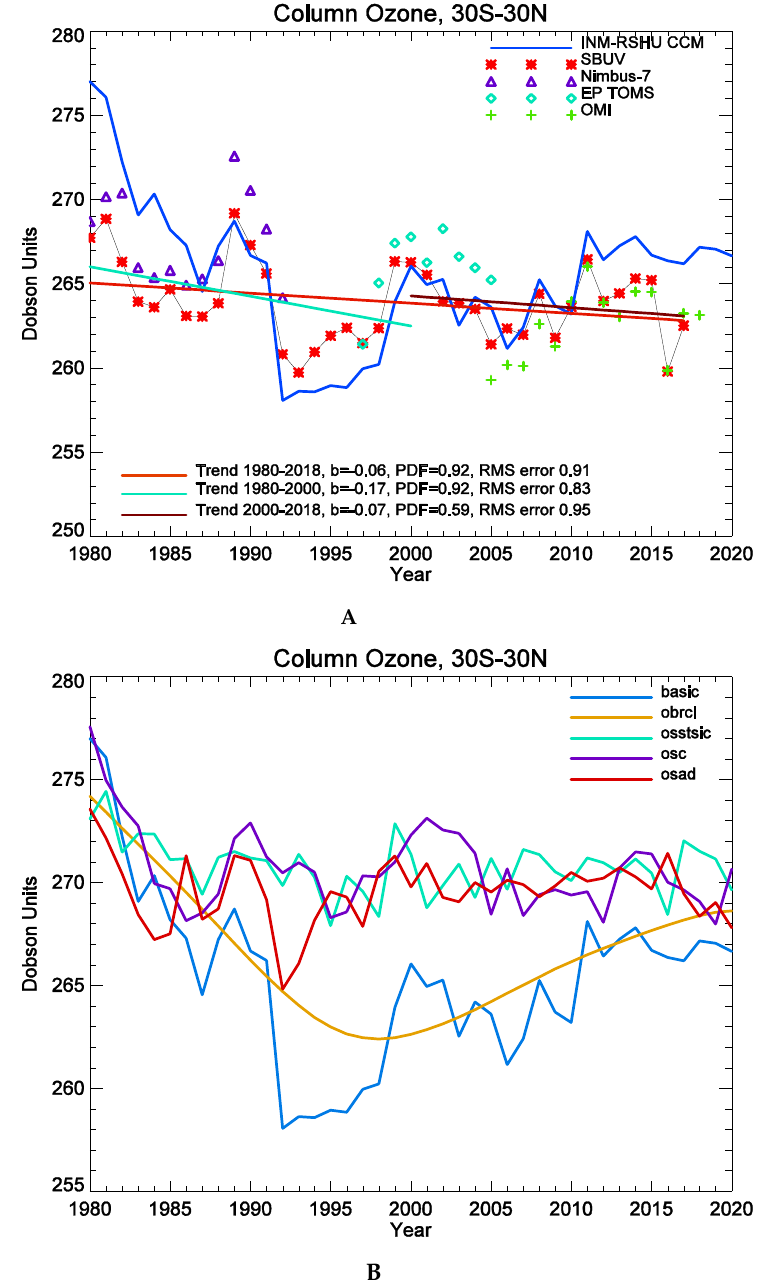
Figure 2. Interannual variability of column ozone in the tropics: ( A ) Results of satellite measurements (solar backscattering ultraviolet (SBUV), Nimbus-7 Total Ozone Mapping Spectrometer (TOMS), Earth Probe (EP) TOMS, and the Ozone Monitoring Instrument (OMI)) and numerical modeling (chemistry–climate model of the Institute of Numerical Mathematics and the Russian State Hydrometeorological University) with an assessment of trends (b—coefficient of linear regression) and their significance (PDF—probability density function, and RMS—root mean square error); ( B ) results of numerical modeling under scenarios with a separate action of influencing factors: basic—all factors’ interannual variabilities are taken into account, obrcl—only the surface emissions of bromine and chlorine-containing gases’ interannual variability is taken into account, osstsic—only sea surface temperature and sea ice coverage interannual variabilities are taken into account, osc—only solar radiation’s interannual variability is taken into account, osad—only sulfate aerosol density’s interannual variability is taken into account.